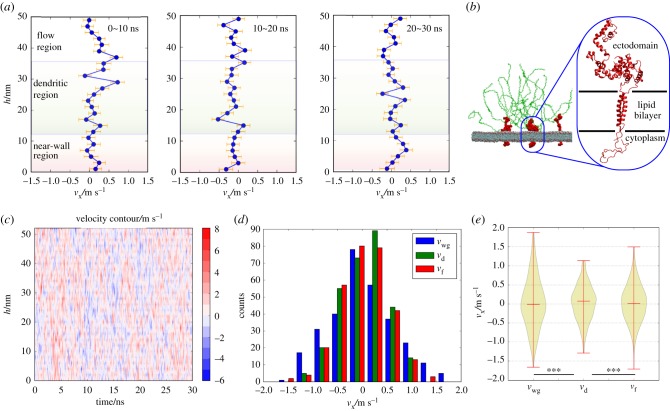
Temporal distributions of velocities at successive intervals and hierarchical velocity distributions across sub-regions. (a) Velocity distributions during periods of 0∼10 ns, 10∼20 ns and 20∼30 ns. (b) α-Helixes are the main secondary structures of ectodomain proteoglycans. (c) Velocity distribution versus height for all recorded frames throughout the 30 ns simulation. (d) Distributions of average velocities in each sub-region for all recorded frames throughout the 30 ns simulation. (e) Velocities ranges within three sub-regions. The flexible sugar chains can reduce the fluctuations of the flow. Statistical significance is given by: *p < 0.05; **p < 0.01; and ***p < 0.001, and p-values can be found in the electronic supplementary material, table S3.